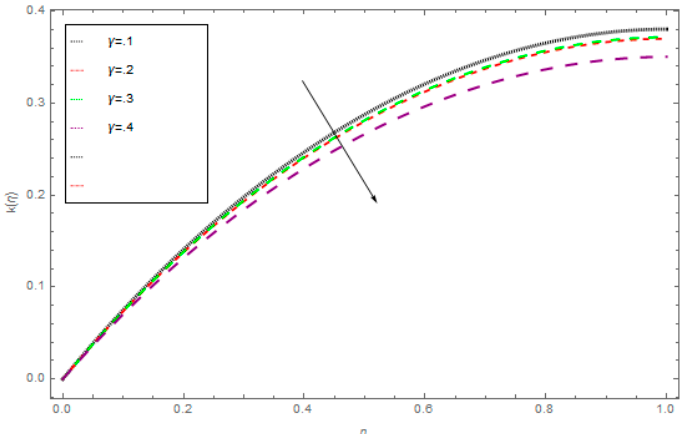
Figure 3. The influence of γ on g ( η ) when Ω = 1, ρ = 1, σ = 0.5, k = 1, M = 1.